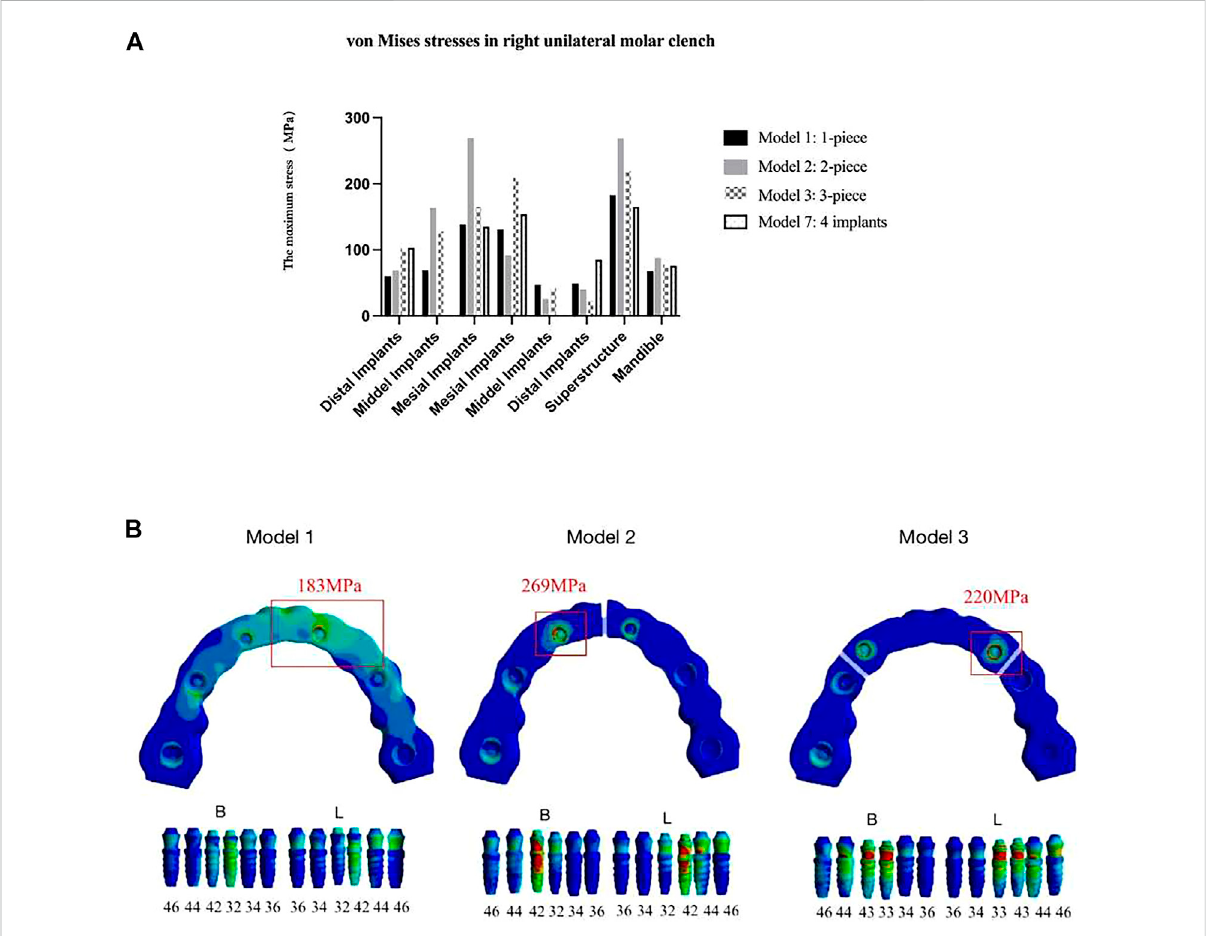
FIGURE 11 VonMisesmaximumstressvalues (A) andpseudo-coloredstressdistribution (B) intherightunilateral molarclenching.Thelargeststressvalues were all recorded around mesial implants in seven models during right molar